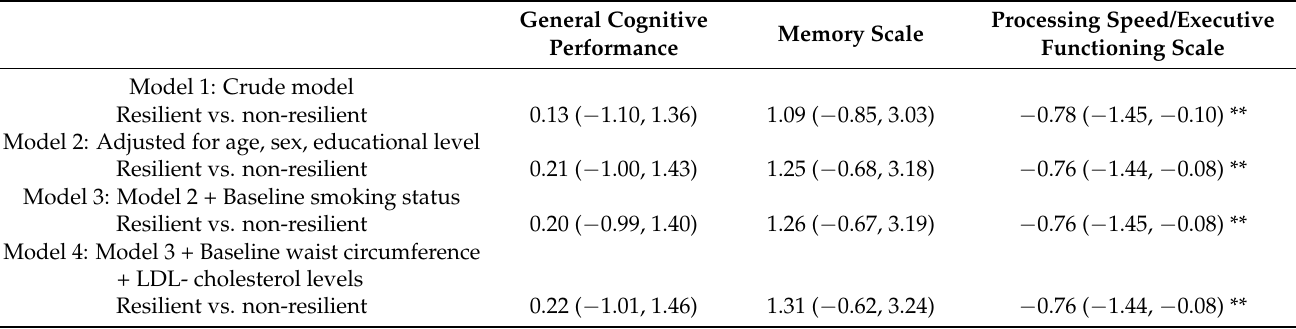
Table 4. Results from the mixed-effects linear models regarding the association of the transition to metabolically unhealthy status with cognitive time trajectories in overweight and obese participants (N =